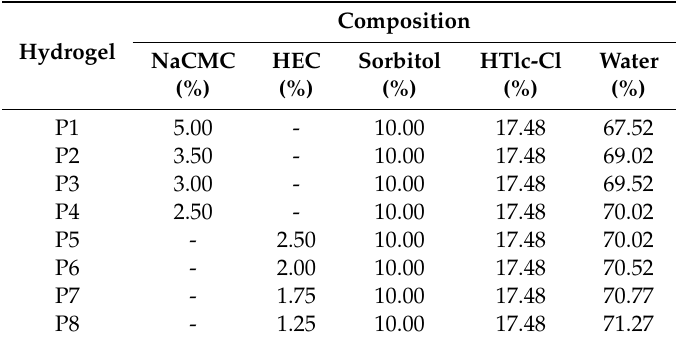
Table 1. First prototypes hydrogels